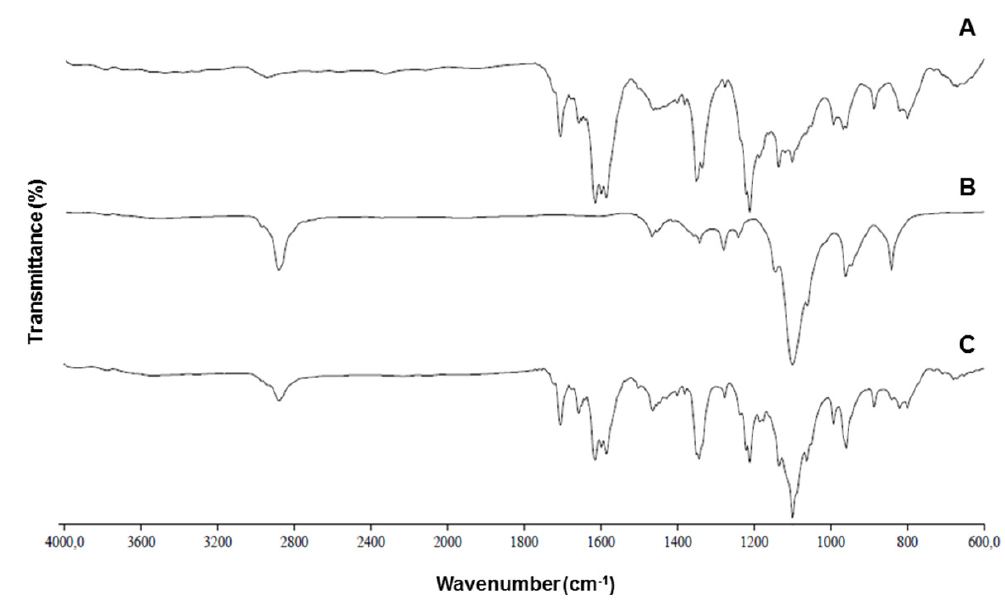
FIGURE 3 – Fourier-transform infrared (FT-IR) spectrum of (A) GF; (B) P407, and (C) GF-P407 physical mixture (1:1,